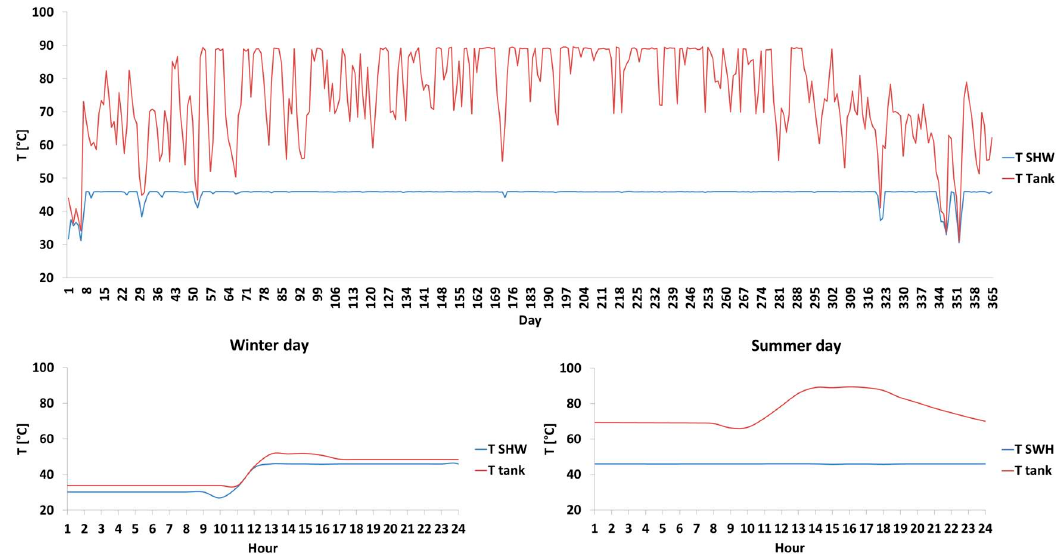
Figure 8. SHW and storage tank temperatures.